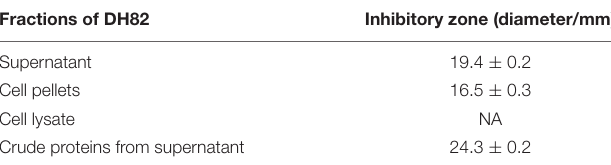
TABLE 2 | Antagonistic activity of DH82 against Vibrio parahaemolyticus